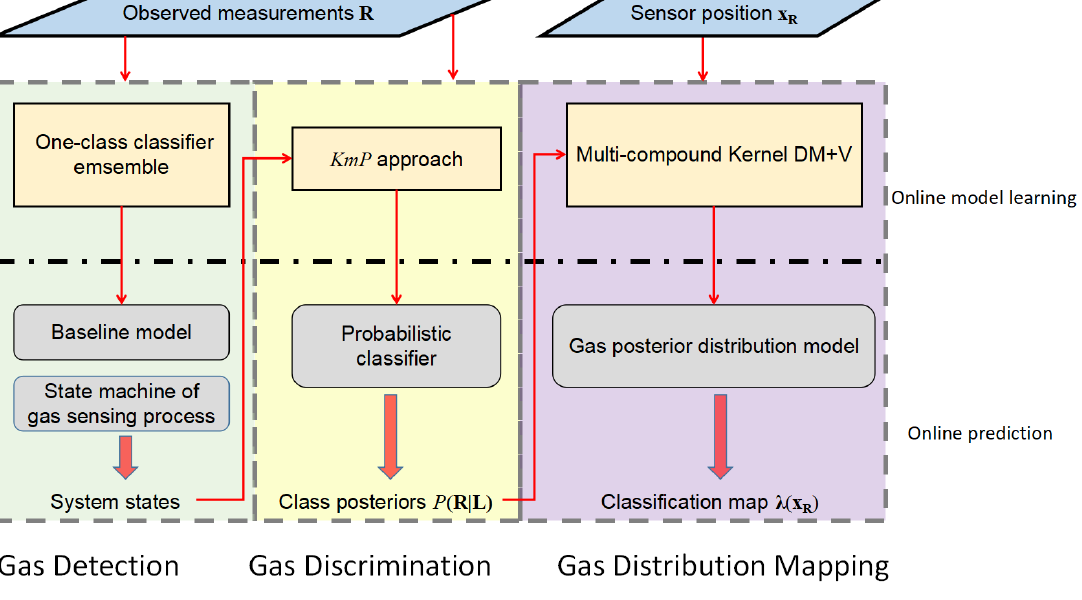
Figure 1. The diagram of the robotic gas-sensing